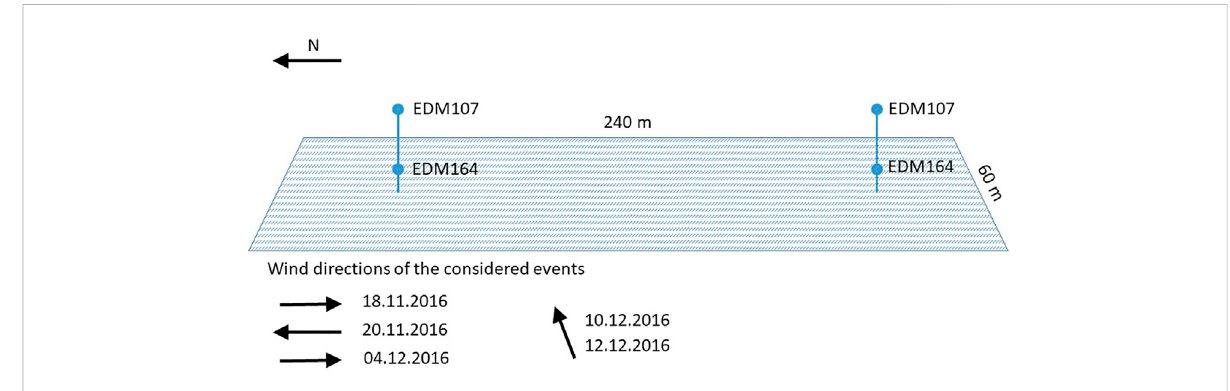
FIGURE 1 Setup of the dust measurements at the fi eld site, arrows mark the wind directions of the regarded erosion